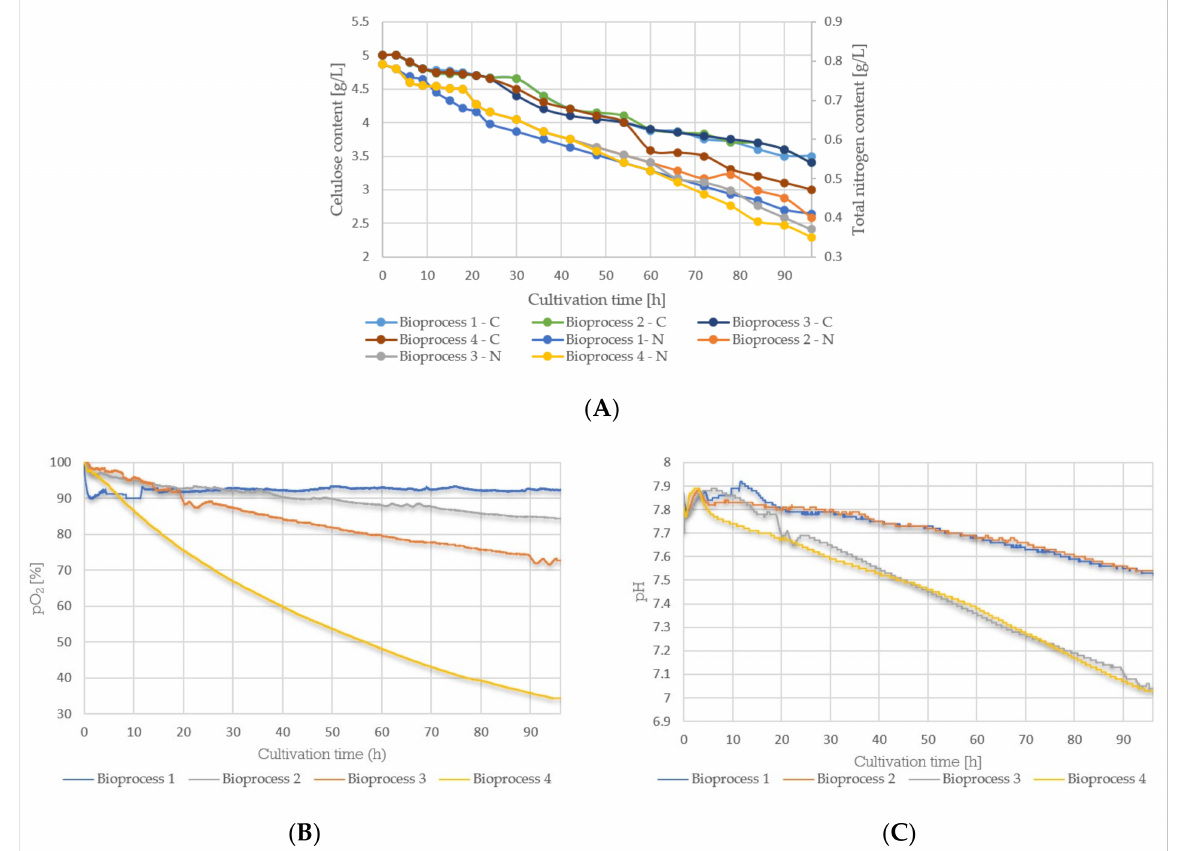
Figure 3. Cultivation of producing microorganism Bacillus sp. BioSol021 in 16 L laboratory bioreac- tor: ( A ) residual concentrations of nutrients (cellulose, total nitrogen); ( B ) oxygen saturation level; ( C ) pH